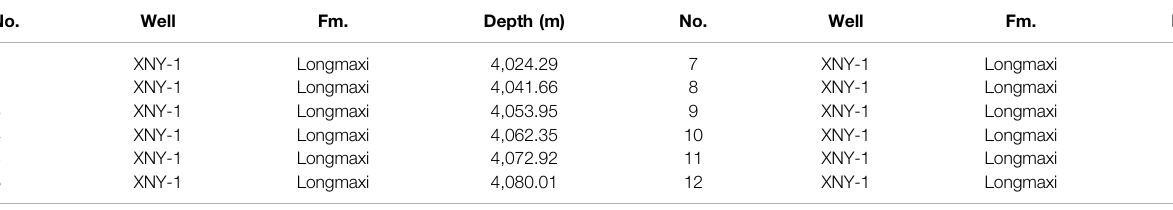
TABLE 2 | Results of mineral composition analysis of core samples. Depth (m) Quartz (%) Potash feldspar (%) Plagioclase (%) Calcite (%) Clay minerals (%) 4,024.29